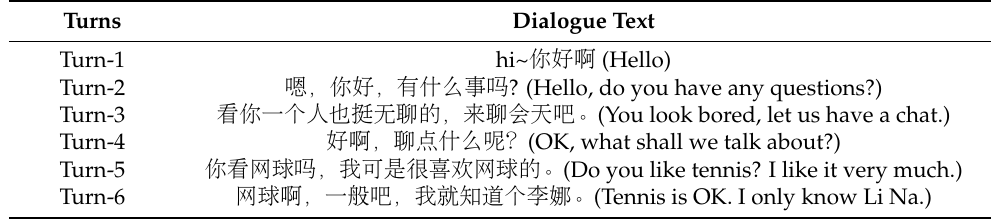
Table 1. Examples of multi-turn